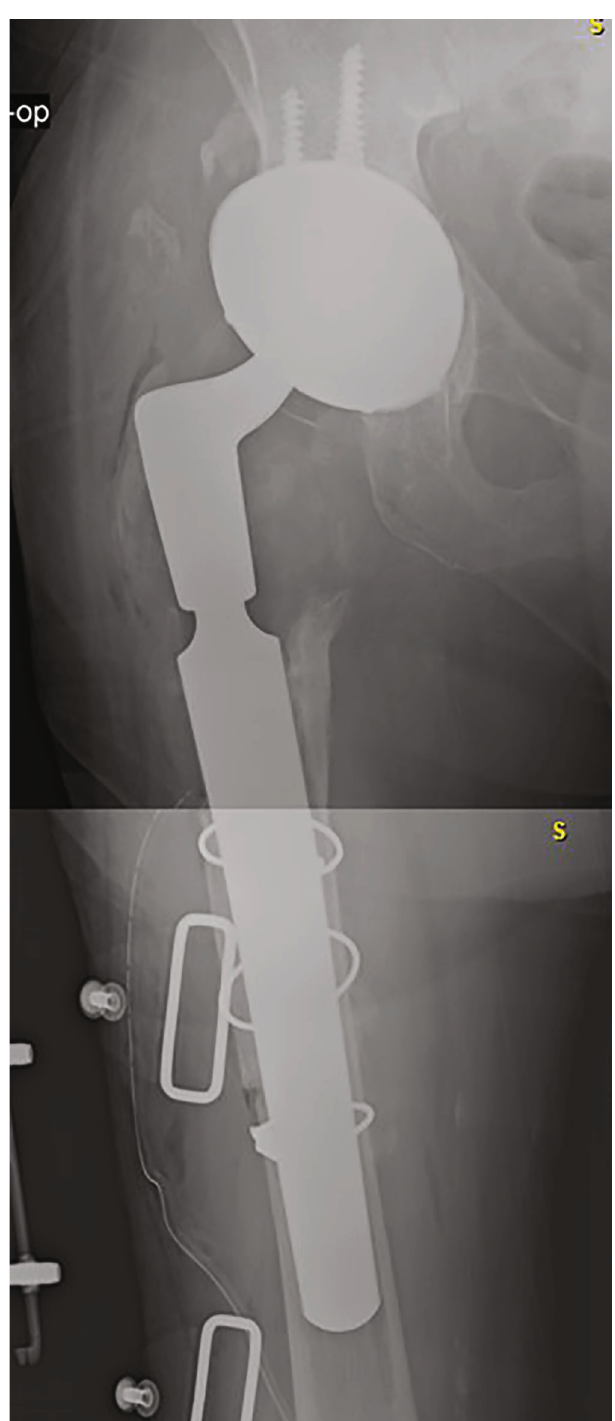
Figure 3: Anteroposterior X-ray of the right hip after reimplantation before fi xation.